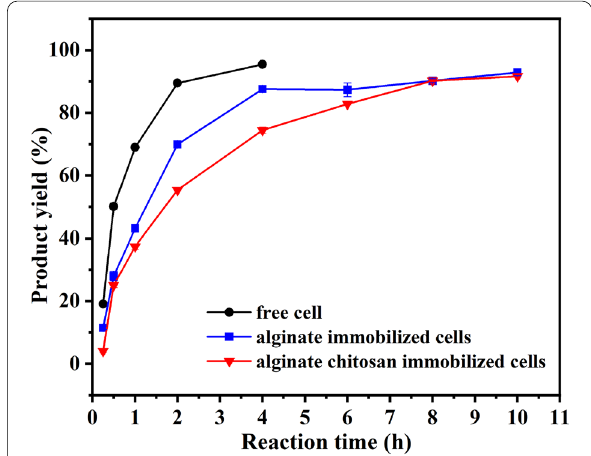
Fig. 1 Reaction course curve of the asymmetric reduction of MAA to ( R )‑HBME catalyzed by free, alginate‑immobilized and alginate chitosan‑immobilized recombinant E. coli cells. Reaction conditions: 4 mL Tris–HCl buffer (200 mM, pH 7.0), 100 mM MAA, 150 mM glucose, 30 mg/mL of free recombinant E. coli cells (wet weight),